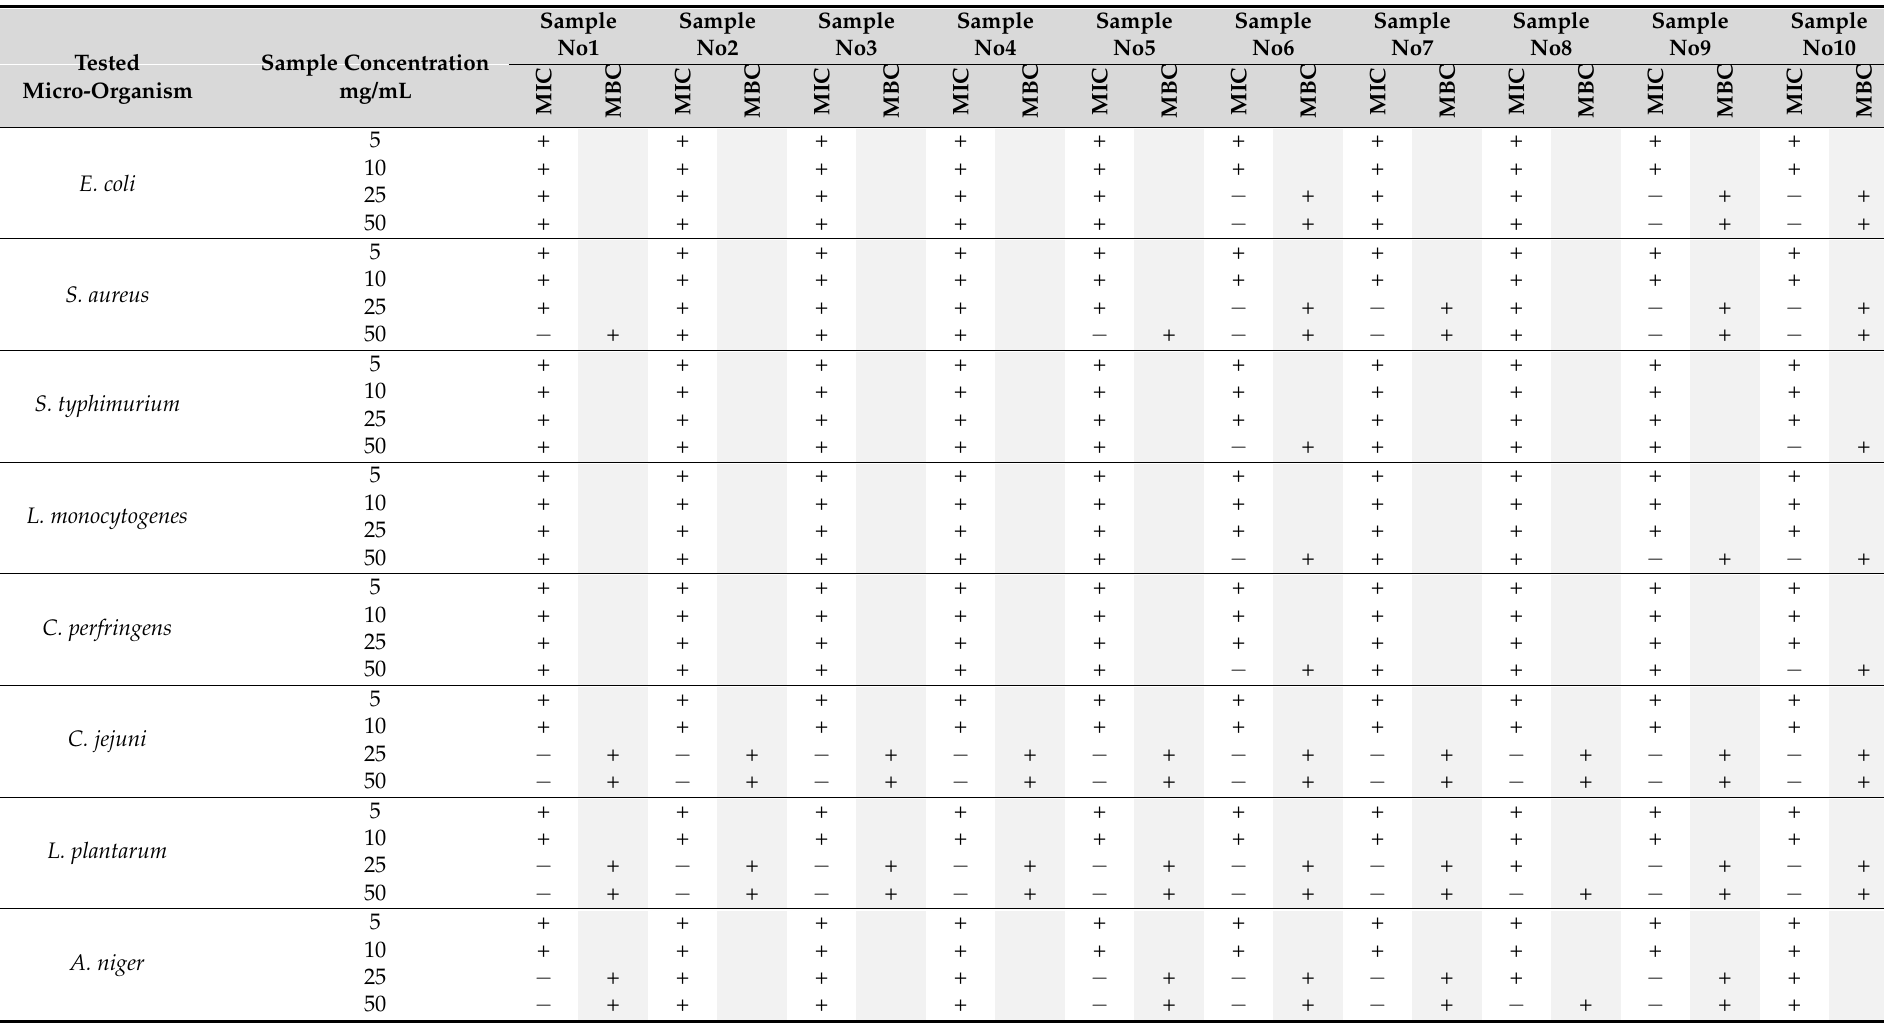
Table 4. MIC/MBC assay results of avocado peel and seed extract and pomegranate peel samples against bacterial pathogens. Values are estimated as means of triplicate measurements.